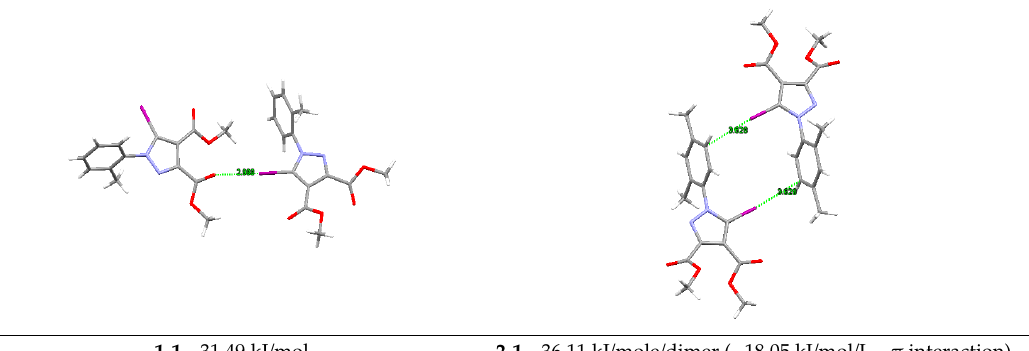
Table 4. Halogen bond interaction dimers and their calculated energies.